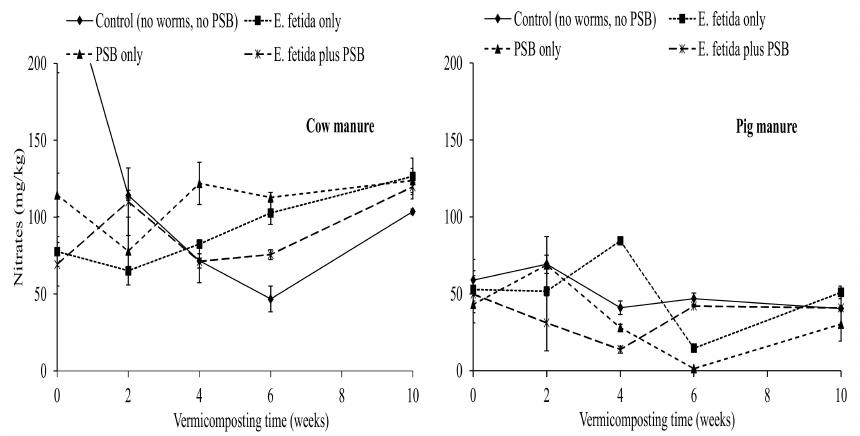
Figure 5. Changes nitrate during vermicomposting of cow and pig manure amended with rock phosphate and P. fluorescence . Error bars indicate standard